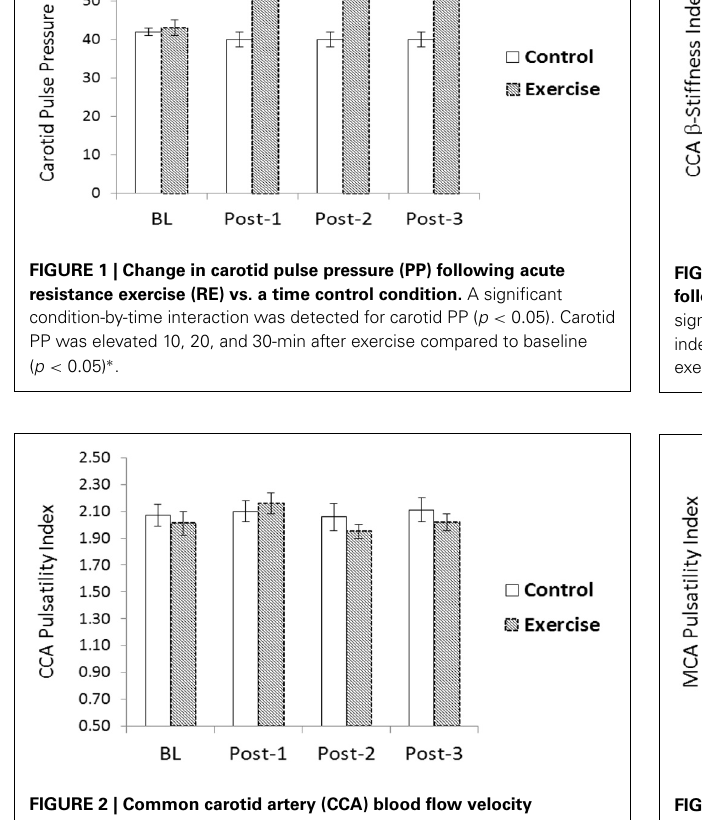
FIGURE 4 | Middle cerebral artery (MCA) blood flow velocity pulsatility index (PI) following acute resistance exercise (RE) vs. a time control condition. No significant changes were noted ( p > 0 .